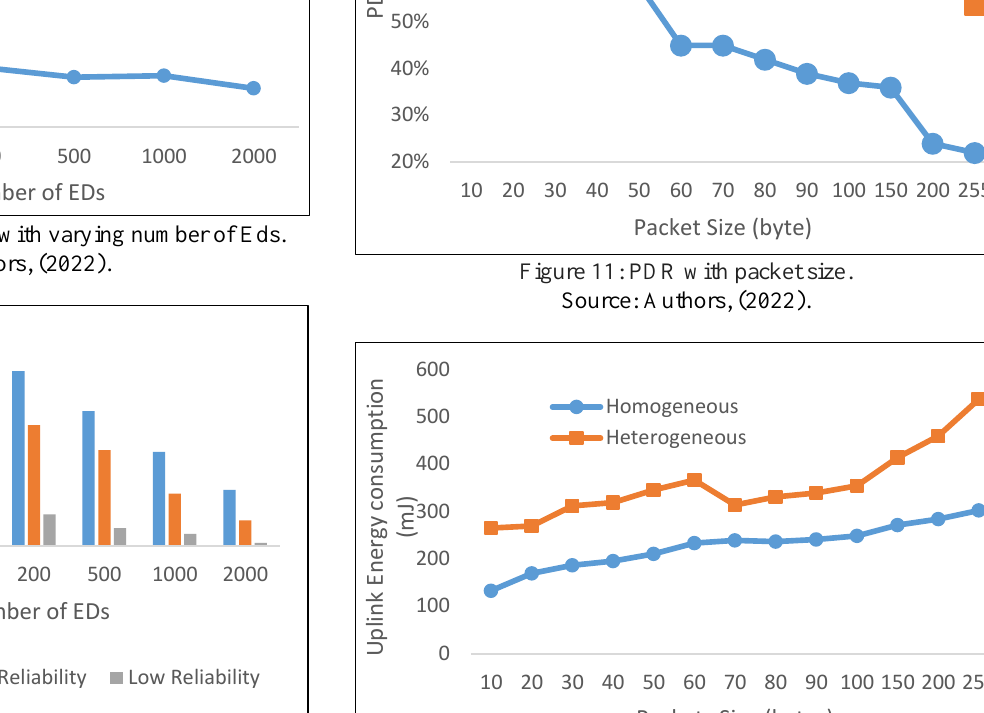
Figure 9: PDR for applications on the Heterogeneous LoRaWAN. Source: Authors, (2022).